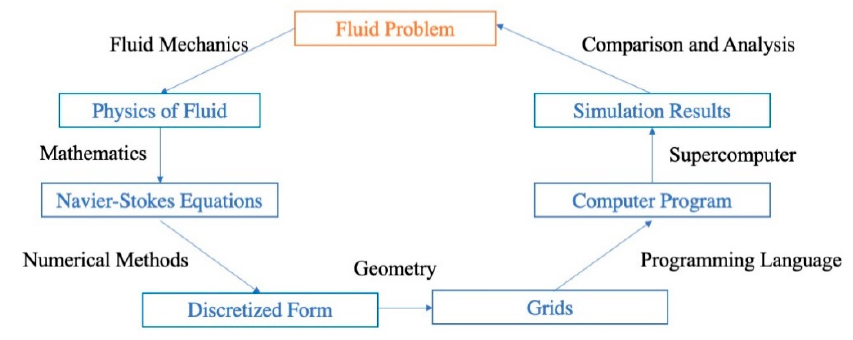
Figure 7. Basic steps of computational fluid dynamics (CFD).